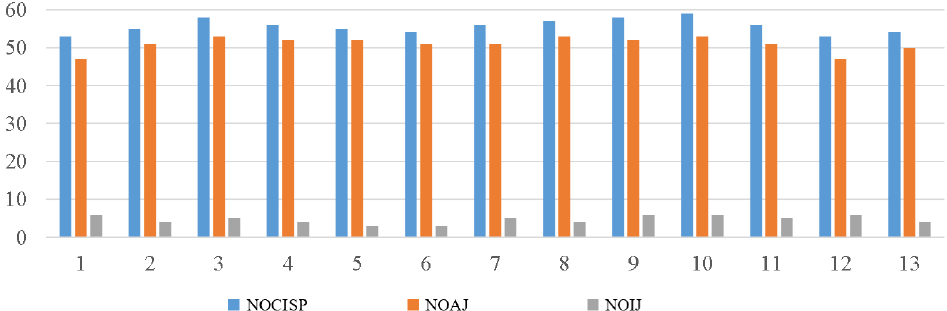
Figure 7. Reliability diagram for the flexible wearable sleeping-position monitoring device. Note: NOCISP = number of changes in sleeping position; NOAJ = number of accurate judgments; NOIJ = number of incorrect judgments.